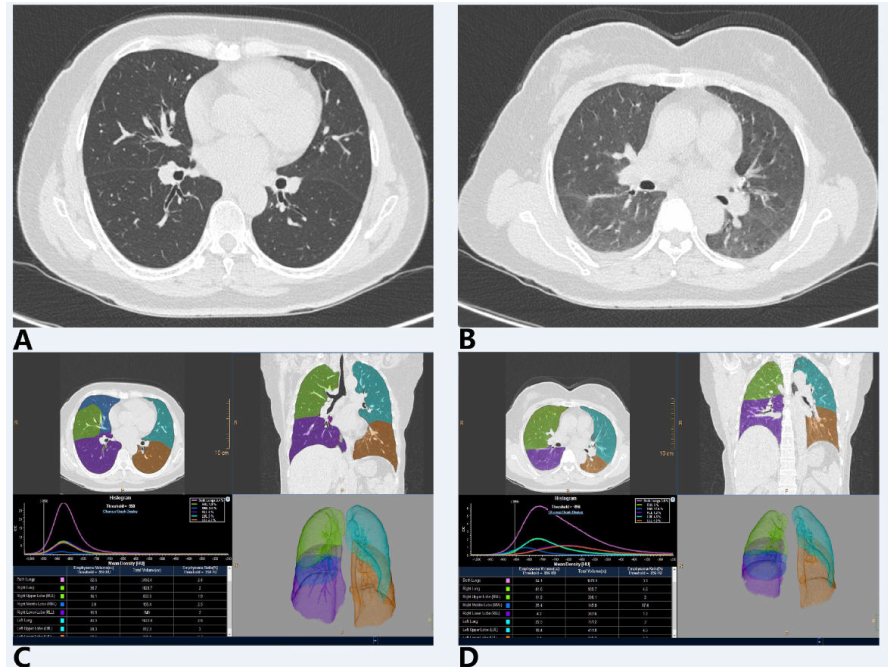
Figure 1. Paired inspiratory–expiratory chest CT image and postprocessing interface. ( A ) Chest CT image at deep-inspiratory phase; ( B ) Chest CT image at deep-expiratory phase; ( C , D )